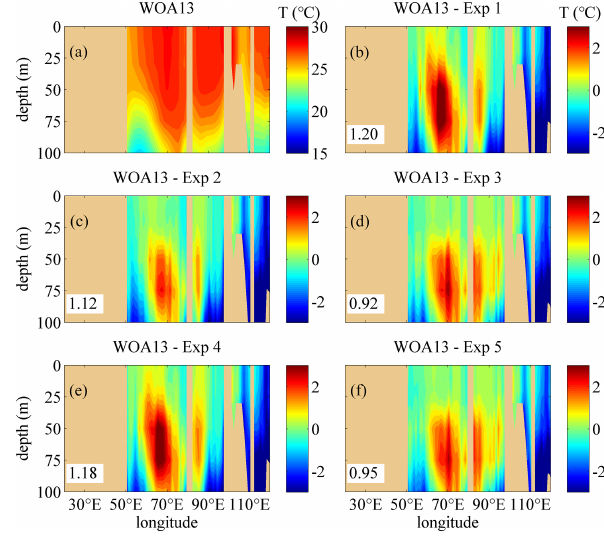
Figure 6. The same as Fig. 4, but along 7.5 ◦ N.